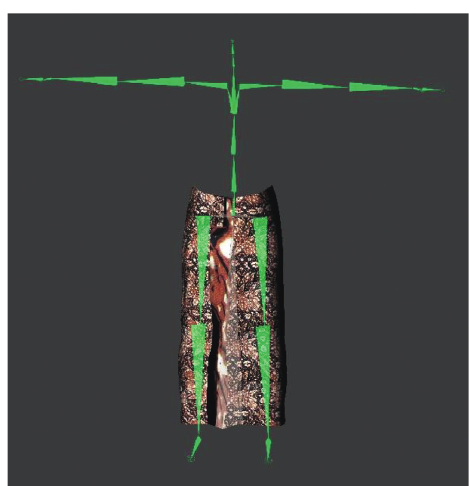
Figure 9: Adding material to the cloth skinned rig.